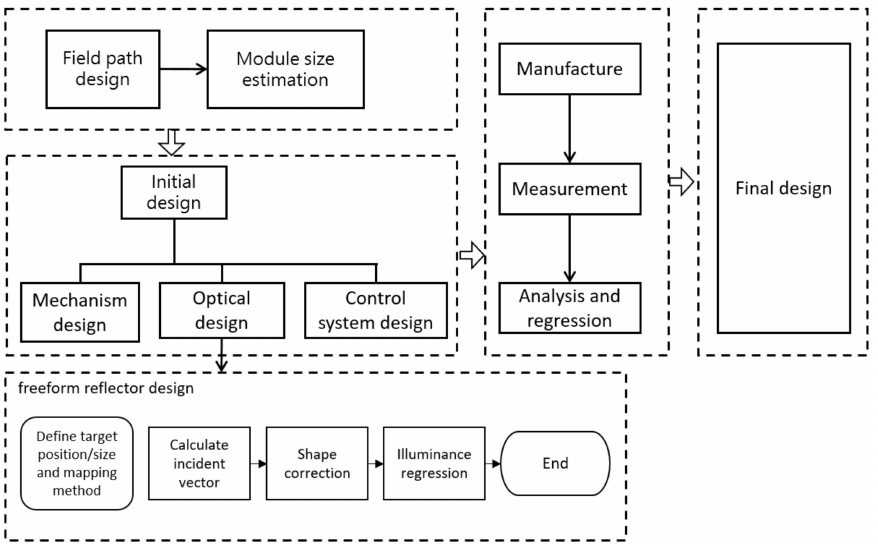
Figure 2. System design diagram.